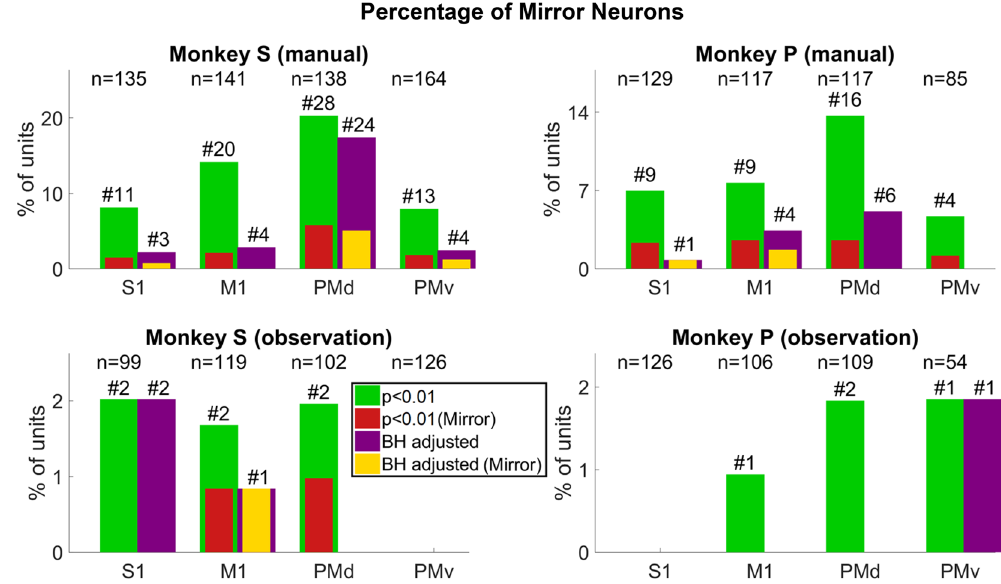
Figure 10. The percentage of single units with force tuning curves that are significantly modulated by reward level. The titles represent which NHP and block type are plotted. P-values were adjusted using the Benjamini– Hochberg method (BH method), correcting for false discovery rate, where the correction was applied using p = 0.01, and the number of hypotheses tests applied was the number of units in the population under study. The y-axis is the percentage of units, and the x-axis represents the cortical region. The green bar is showing the number of significant units (p < 0.01, ANCOVA), and red shows the MN population among them. The purple bar is showing the significant units after the BH method was applied. The yellow bar inside the purple is showing the percentage of putative MNs after the BH method. The number after the ‘#’ sign on top of each bar shows the number of significant units for that given case, and the number presented with ‘n’ is the total units recorded for that